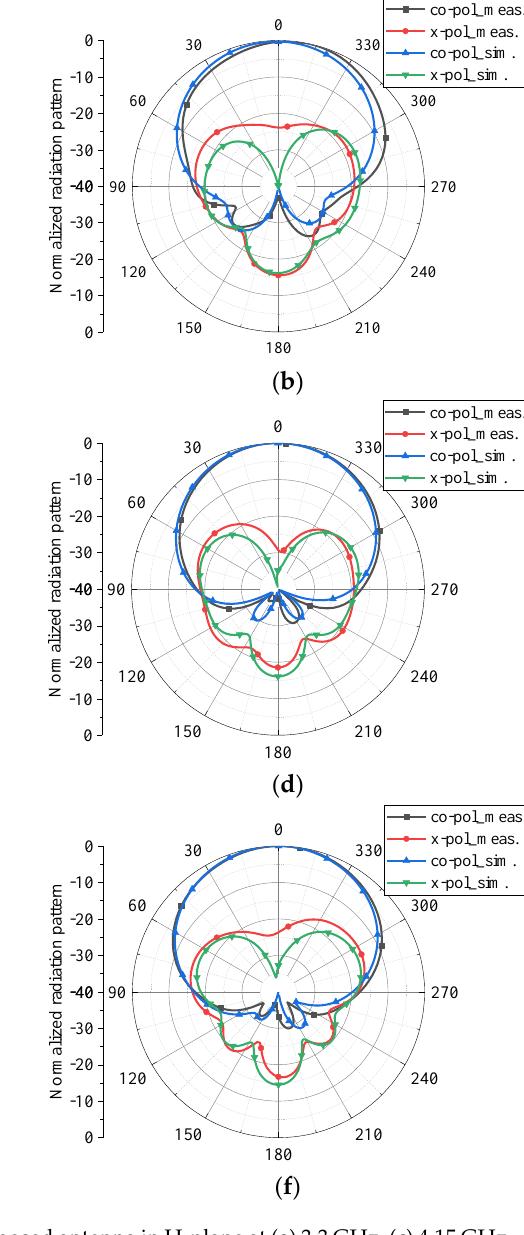
Figure 6. Normalized radiation patterns of the proposed antenna in H-plane at ( a ) 3.3 GHz, ( c ) 4.15 GHz, and ( e ) 5.0 GHz, and in V-plane at ( b ) 3.3 GHz, ( d ) 4.15 GHz, and ( f ) 5.0 GHz, excited by port